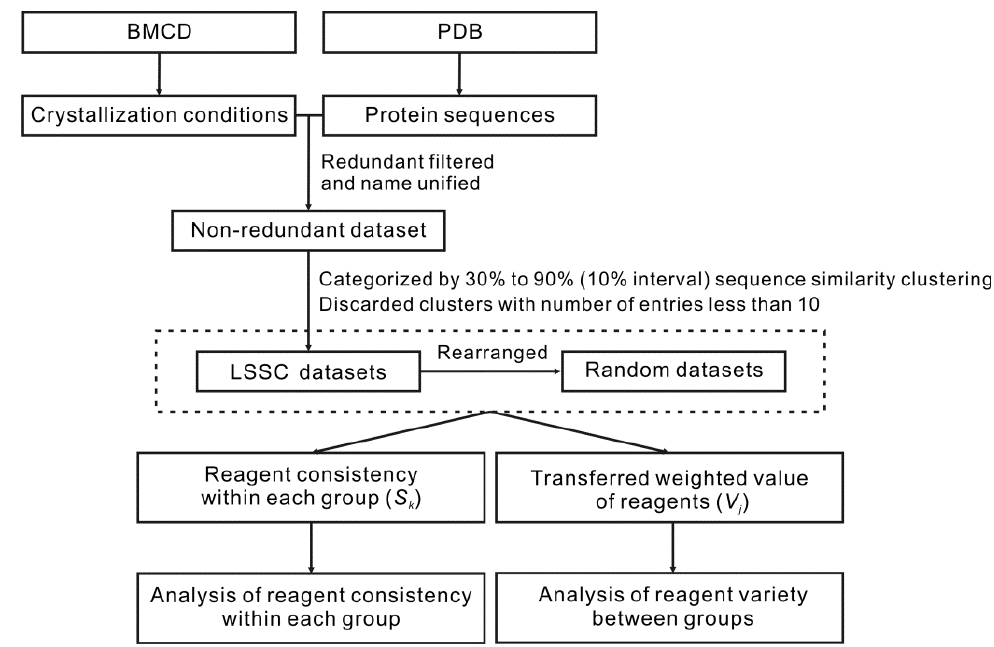
Figure 4. The analysis strategy and process of this